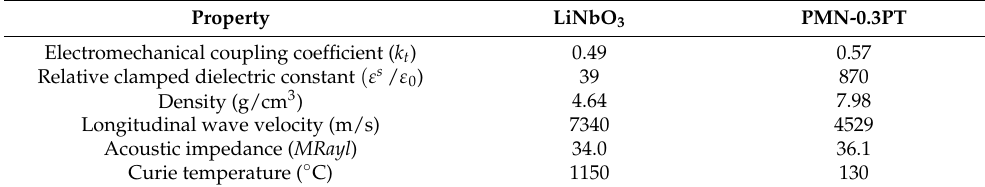
Table 1. Important material properties of 36 ◦ rotated Y-cut lithium niobate 1 and PMN-0.3PT 2 .